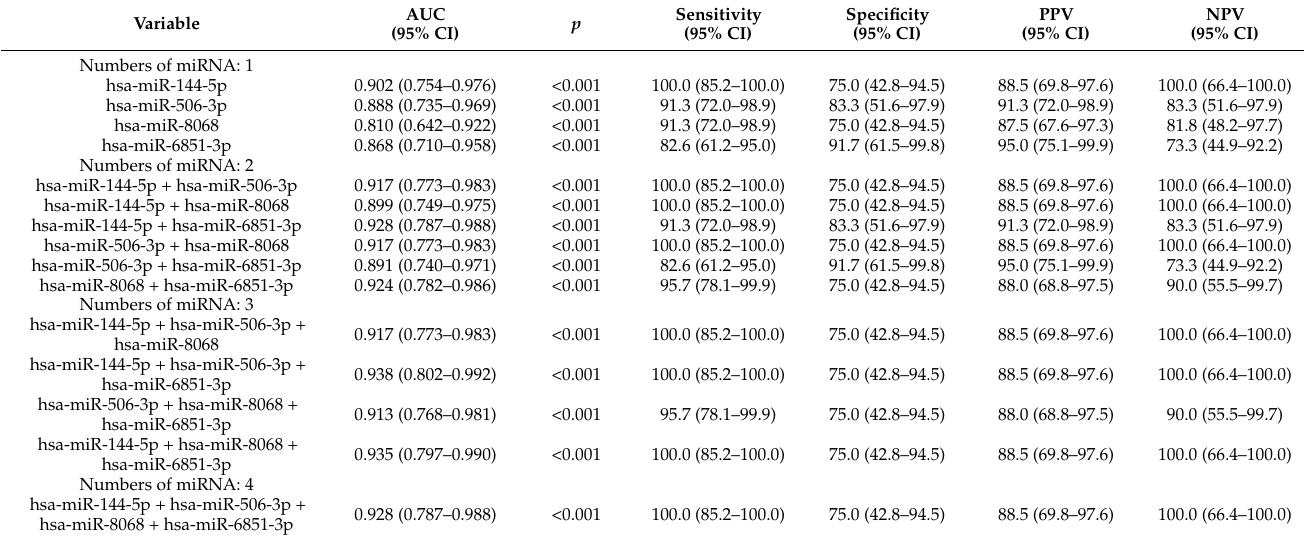
Table 2. Performance characteristics of the miRNAs for diagnosing PMOP (validation set).